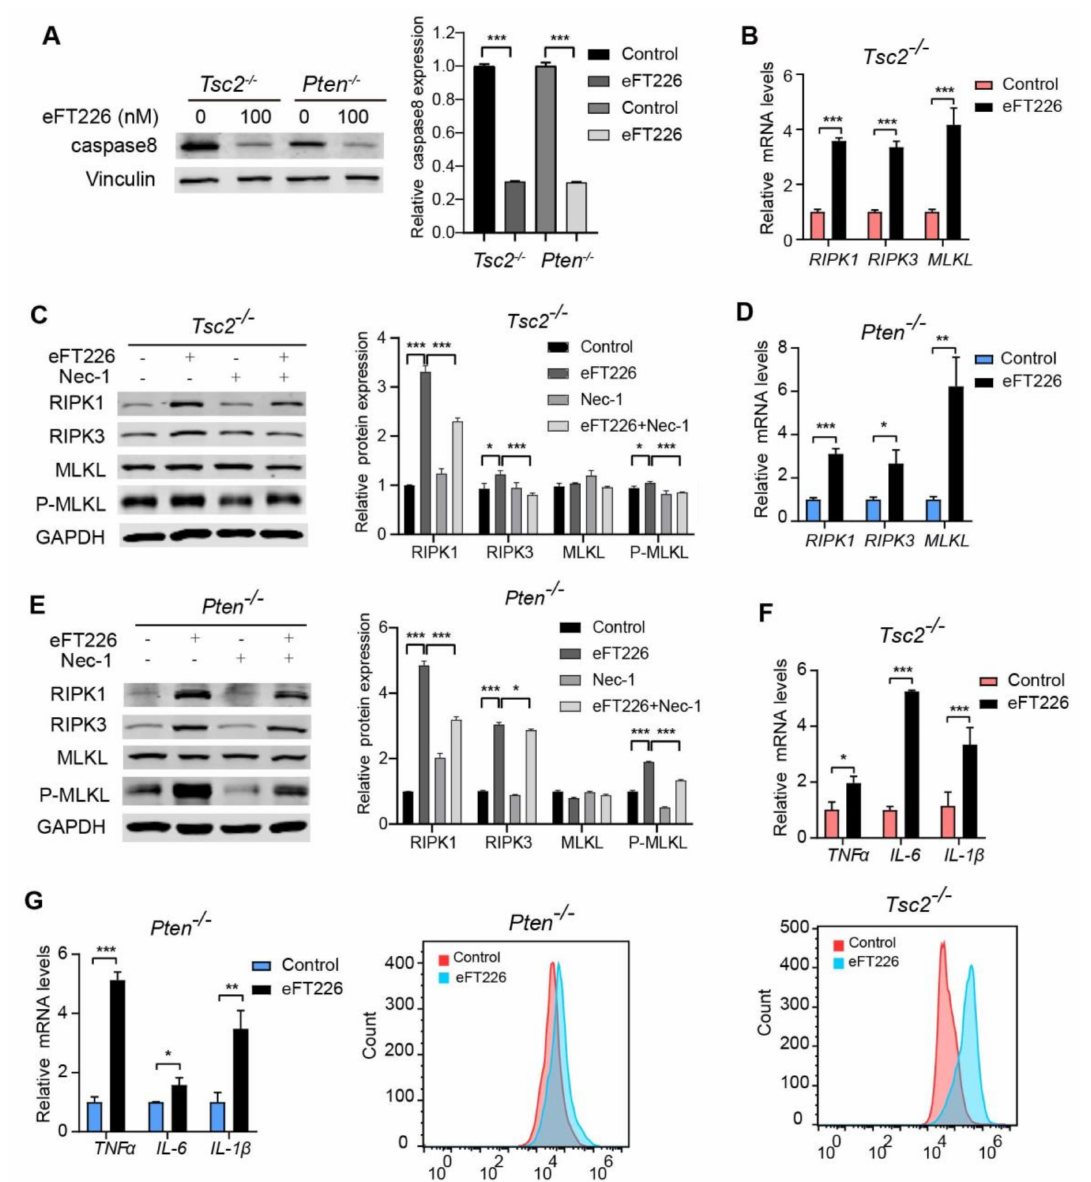
Figure 4. eFT226 activates RIPK1/RIPK3/MLKL pathway. ( A ) Immunoblot analysis of caspase8 protein in Tsc2 - and Pten -deficient MEFs after treatment with eFT226 (100 nM) for 48 h ( left ). Quanti- tative analysis of protein band density was shown in right panel. ( B ) Effects of RIPK1, RIPK3, and MLKL mRNA expression in the Tsc2 - deficient MEFs was determined by RT-PCR. ( C ) The levels of necroptosis proteins were analyzed by immunoblotting after eFT226 (100 nM) treatment with or without Nec-1 in Tsc2 - deficient MEFs ( left ). Quantitative analysis of protein band density was shown in right panel. ( D ) mRNA expression level of RIPK1, RIPK3, and MLKL in the Pten -deficient MEFs was determined by RT-PCR. ( E ) The levels of necroptosis proteins were analyzed after eFT226 (100nM) treatment with or without Nec-1 in Pten -deficient MEFs ( left ). Quantitative analysis of protein band density was shown in right panel ( right ). Tsc2 - ( F , top ) and Pten -deficient MEFs ( G , left ) were treated with eFT226 (100 nM) for 48 h and mRNA levels of TNF- α , IL-6 , and IL-1 β were measured by RT-PCR. ROS levels were measured in Tsc2 - ( F , bottom ) and Pten -deficient MEFs ( G , right ) by flow cytometry using DCFH-DA probe after treatment with eFT226 (100 nM) in triplicate for 48h. All quantitative RT-PCR reactions were performed at least in triplicate. Values are mean ± S.D. of 3 independent experiments in comparison with the control. * p < 0.05; ** p < 0.01; and *** p <